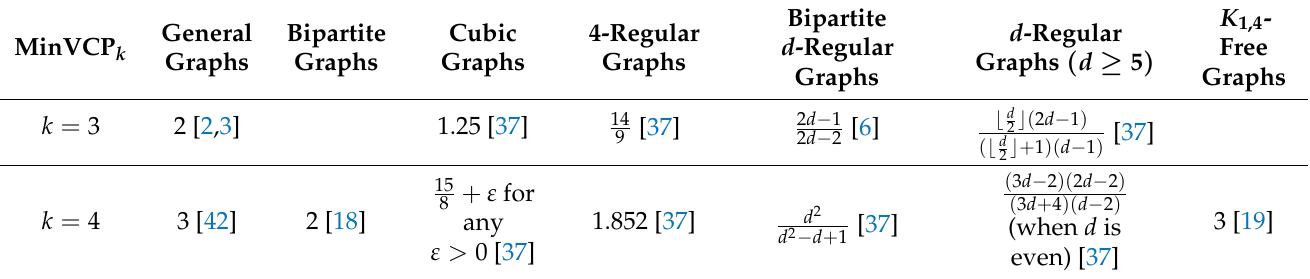
Table 1. The best approximation ratios for MinVCP 3 and MinVCP 4